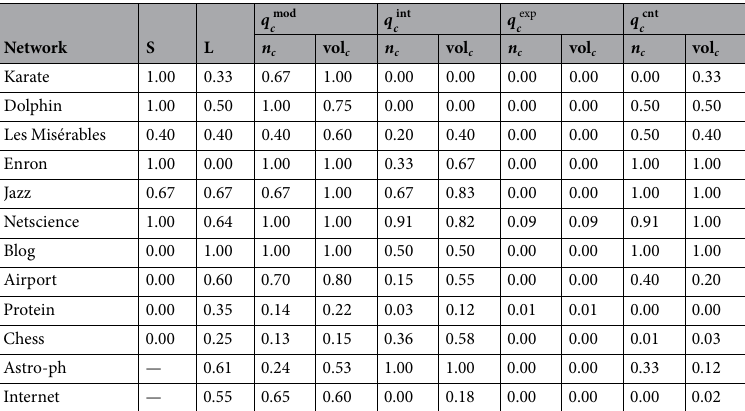
Table 2. Fraction of significant communities identified by the S–test, the L–test, the ( q mod , s )–test, the ( q int